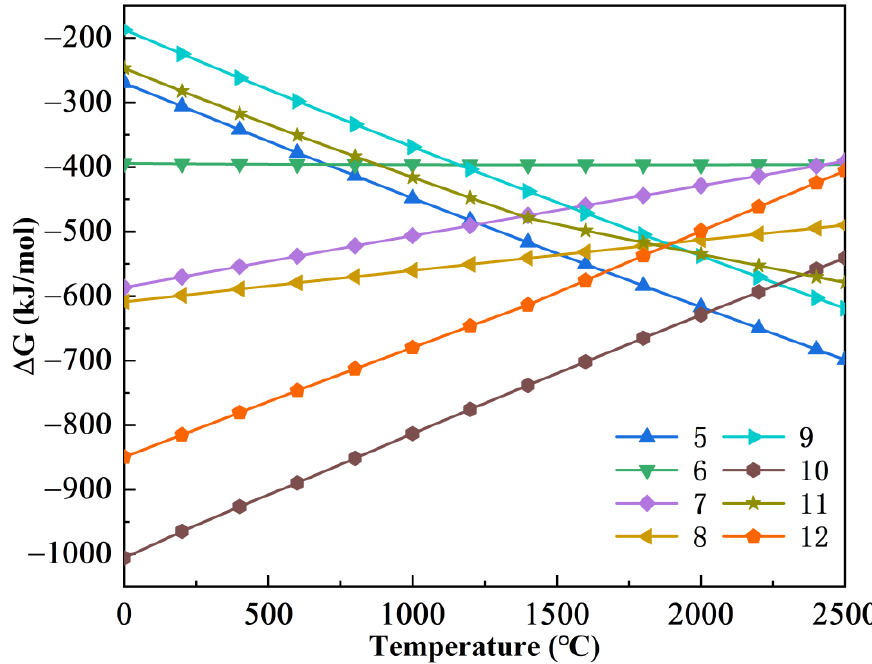
Figure 10. Gibbs free energy change (Δ G ) versus the temperature curves.